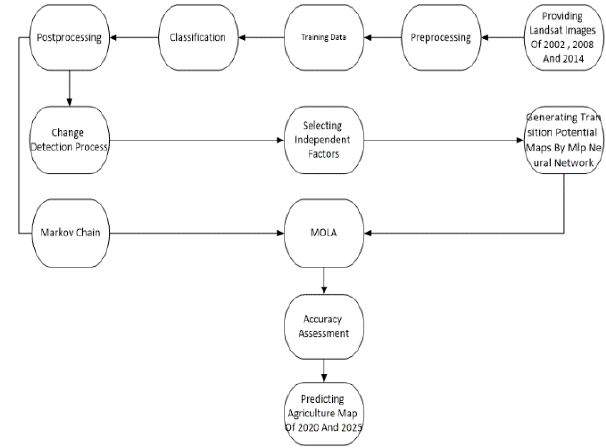
Figure 3. Flowchart of the proposed method Support Vector Machine (SVM) classification is based on the theory of statistical learning and aims to determine the boundaries of decision making that optimize the separation